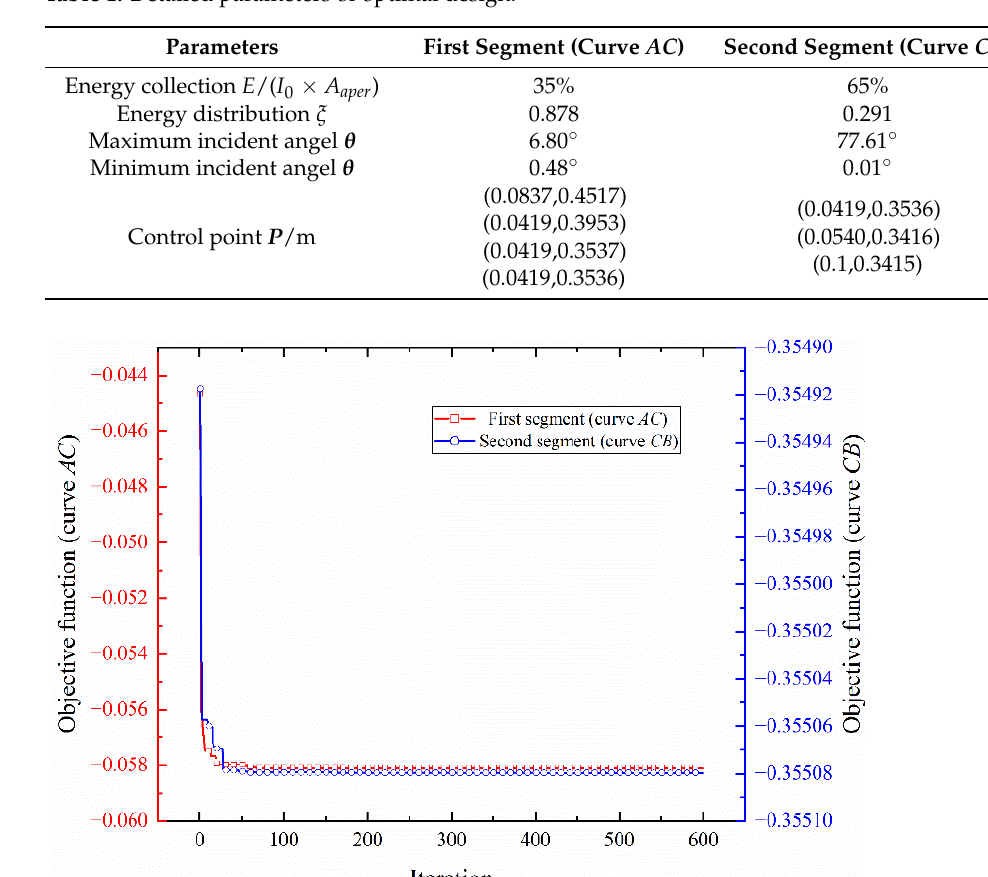
Figure 7. Iteration curve of the objective function for two-segment design.